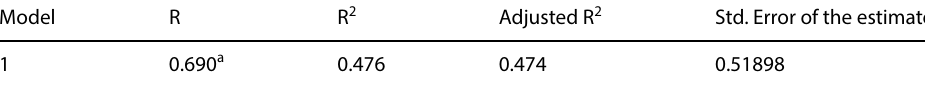
Table 3 Analysis of R 2 for the model